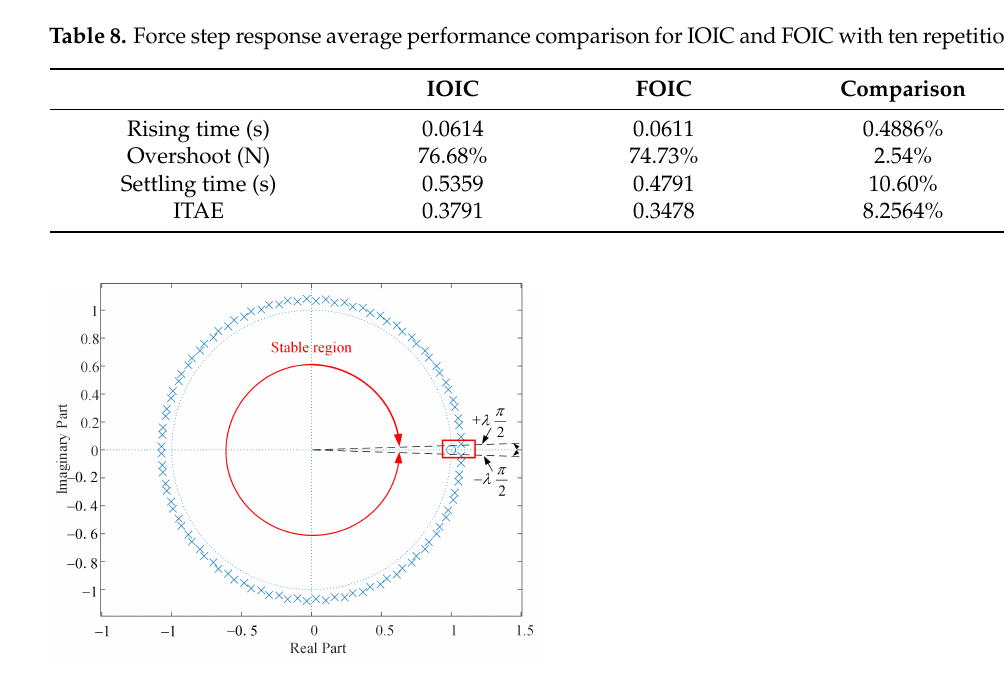
Figure 16. Pole plot of the designed FOIC closed-loop control